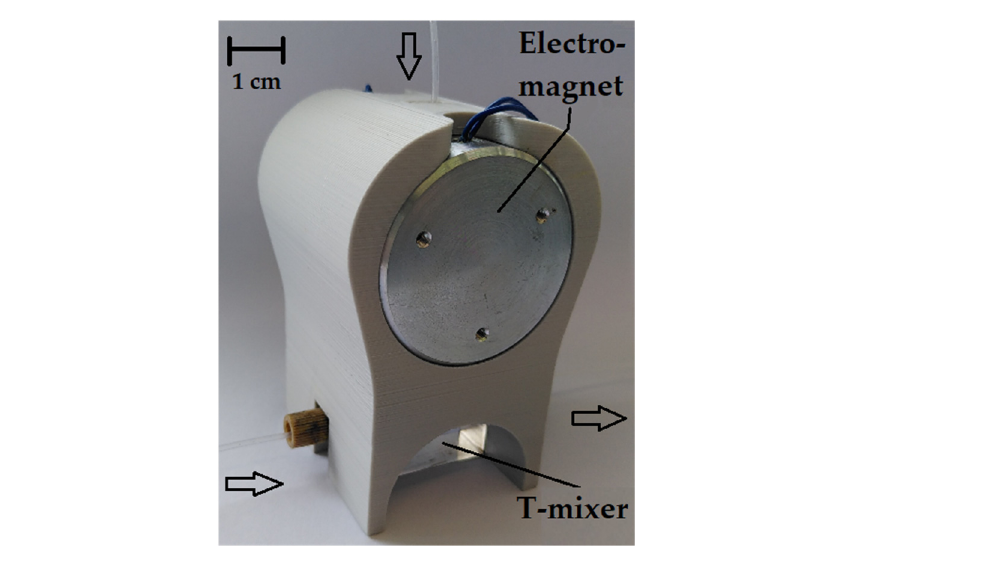
Figure 7. 3D-printed setup of the phase controller with connected capillaries.